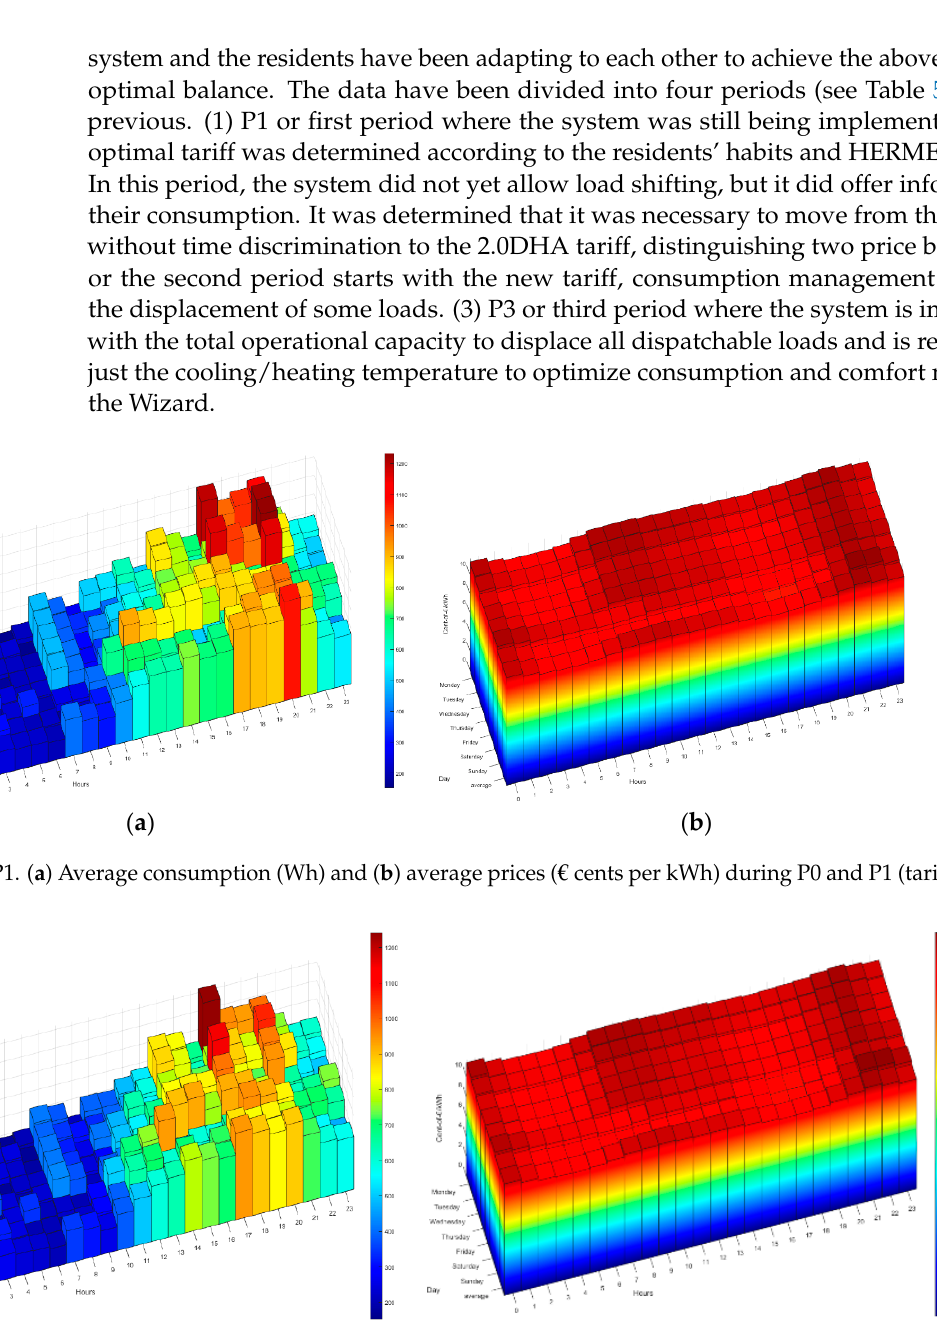
Table 5. Phases of incorporation of HERMES system functionalities.